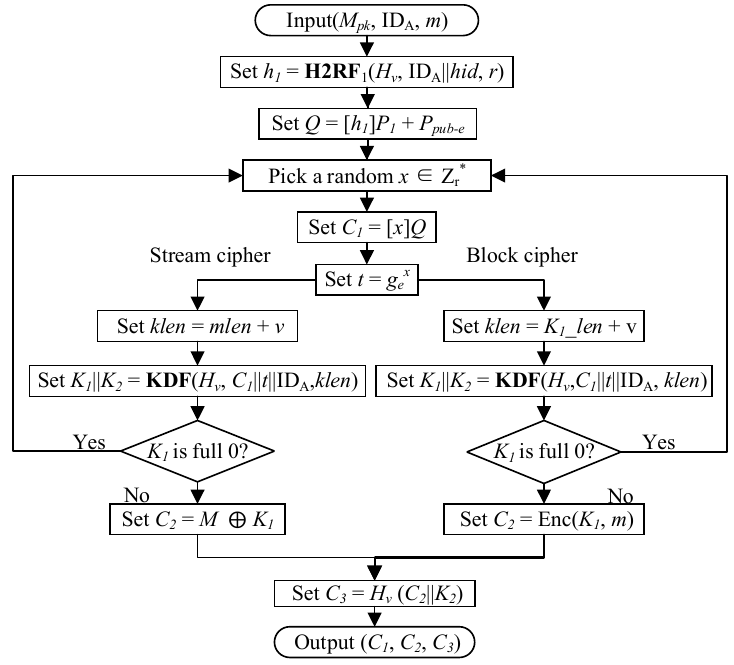
Figure 2. Encryption algorithm flow.